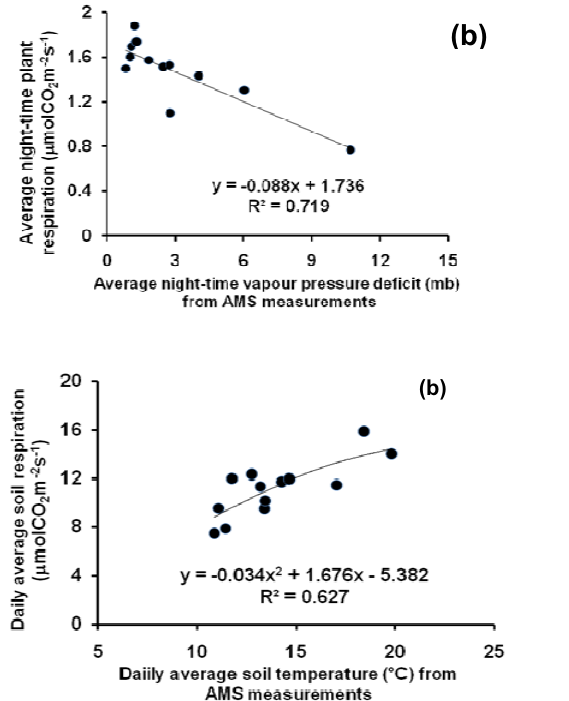
Figure 5. Relations of (a) night-time plant respiration and (b) soil respiration with micrometeorological